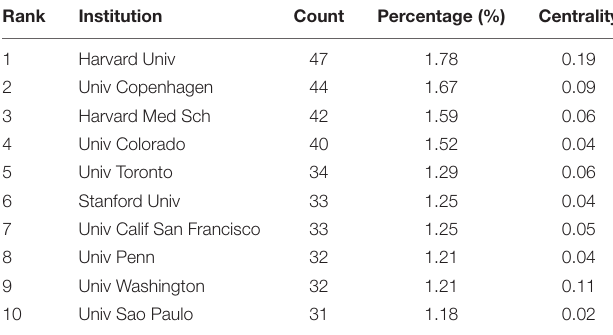
TABLE 3 | The top 10 prolific institutions in physical activity therapy for diabetes research.